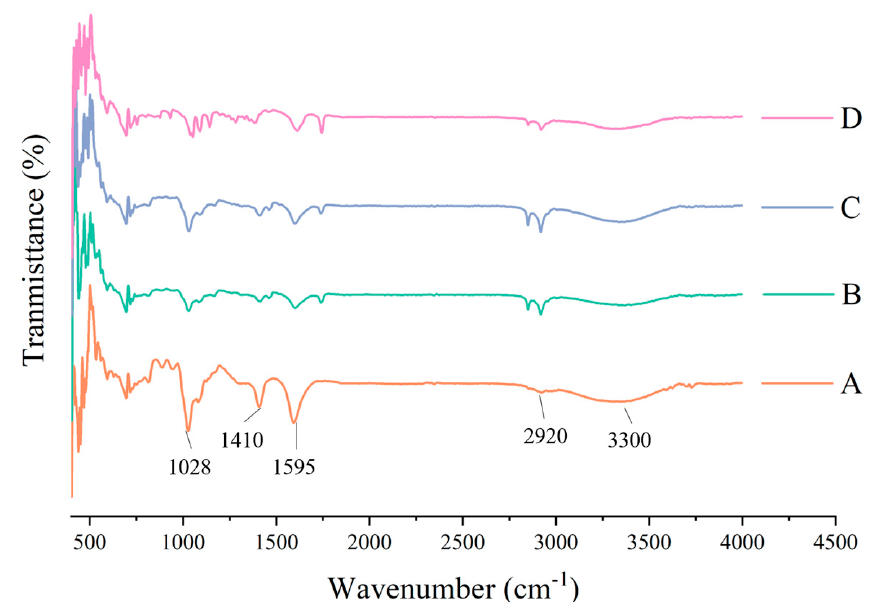
Figure 5. Effect of each component on the chemical bond of composite film (A: pure SA membrane; B: SA/CW composite membrane; C: SA/CW/G composite membrane; D: SA/CW/G/Vc-Ca composite membrane).